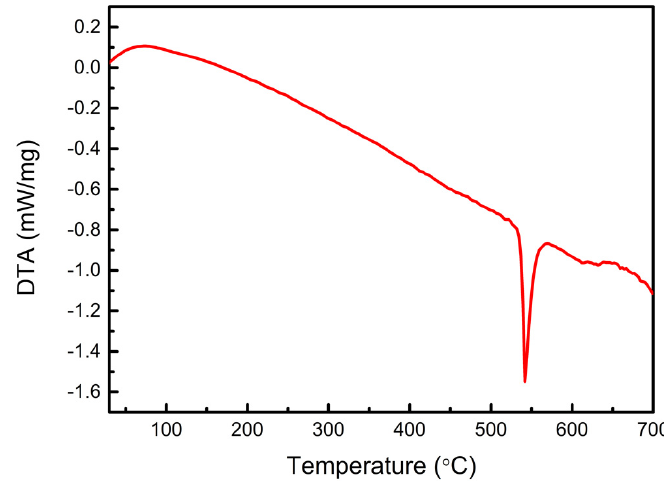
Figure 2. DTA result of the amorphous FeSiCrB alloy powder.